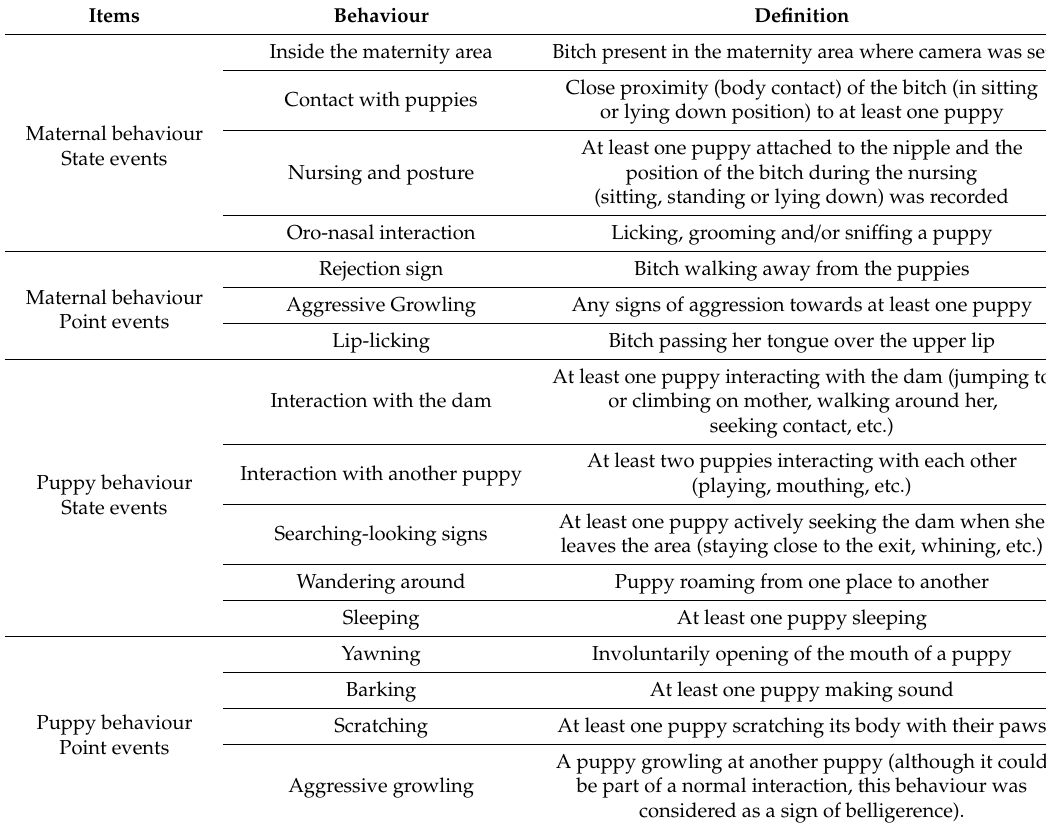
Table 1. Classification of maternal and puppy behaviours assessed through video recording throughout the weaning